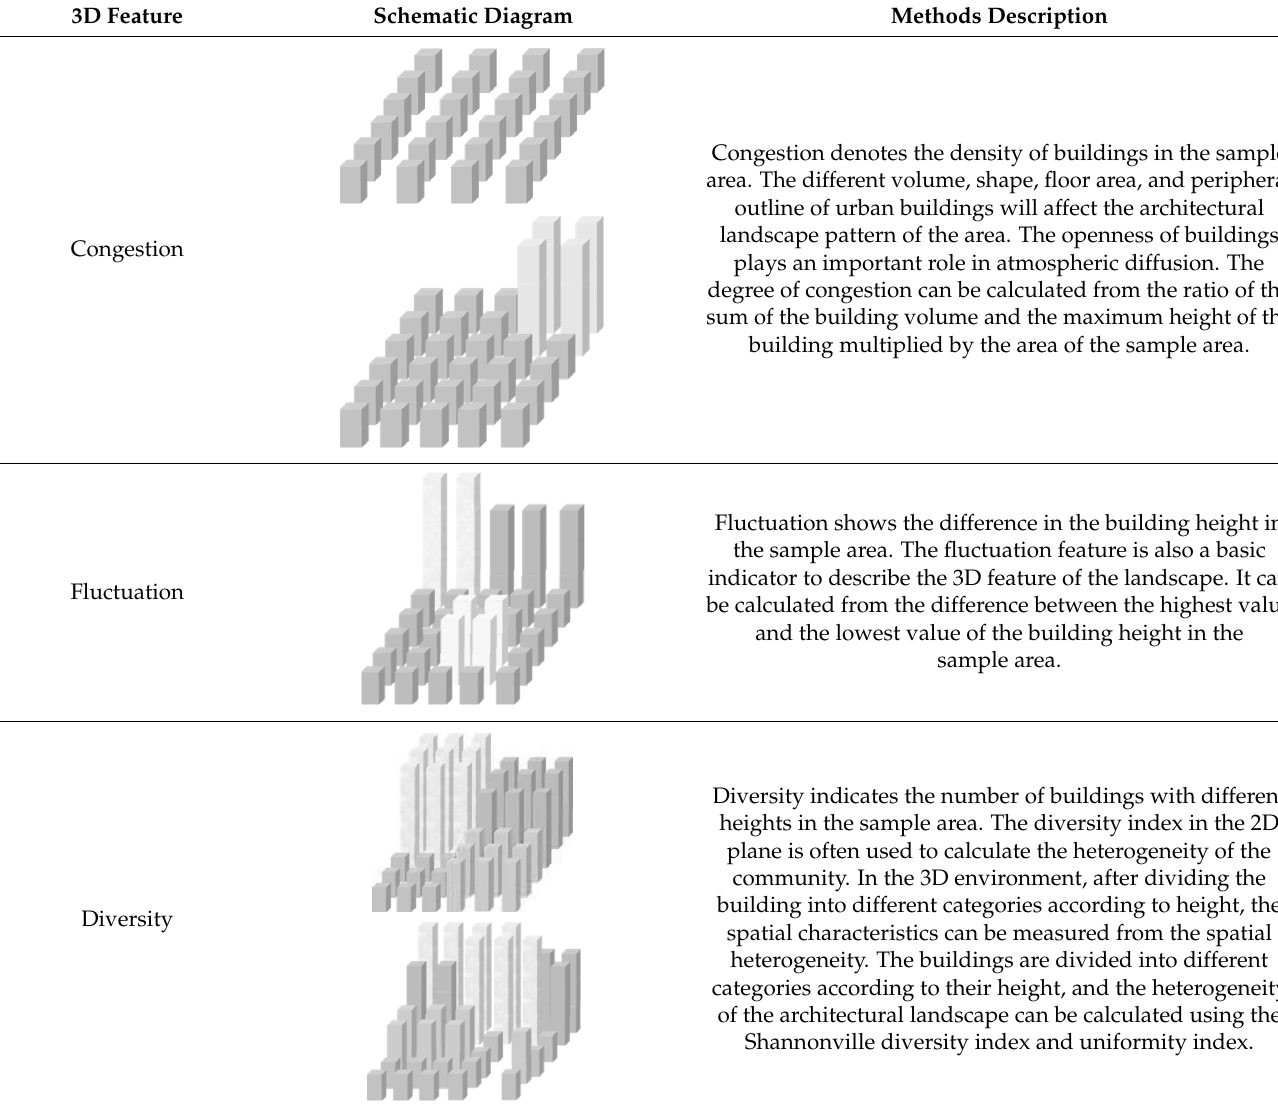
Table 2. Formulas of 3D landscape indices.